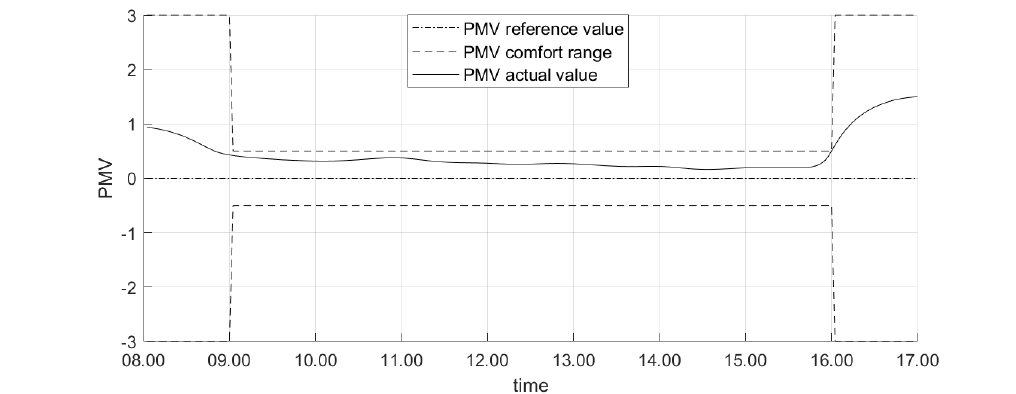
Figure 6. The PMV profile in the demo site in a midweek day in June 2019.